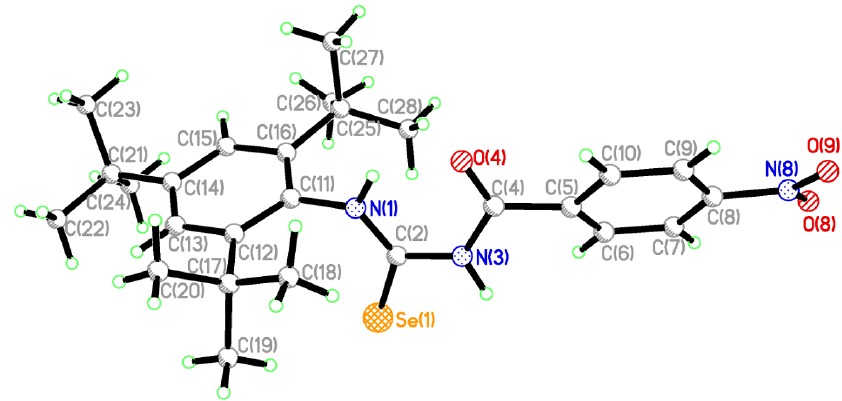
Figure 1. Single crystal X-ray structure of compound 2 (hydrogens represented as small green